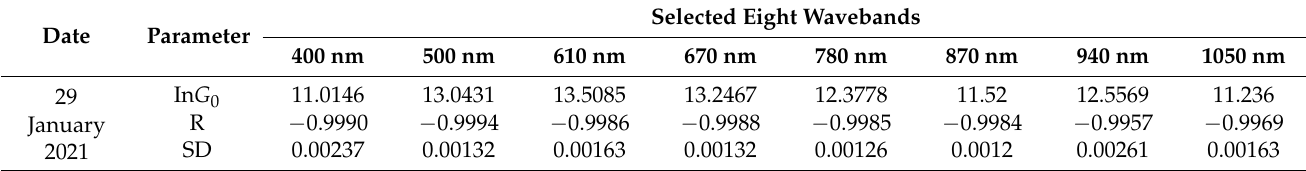
Figure 9. Illustration of linear relation between log radiometer voltage and optical airmass. Calibration value In G 0 , correlation coefficient R, and standard deviation SD of eight selected bands are shown in Table 2. The correlation coefficient of each waveband is above 0.995, and the standard deviation is lower than 0.003. This indicates that least-squares fitting of the line through the data points on 29 January 2021 yields ideal results. Table 2. Calibration value, correlation coefficient and standard deviation of eight bands.